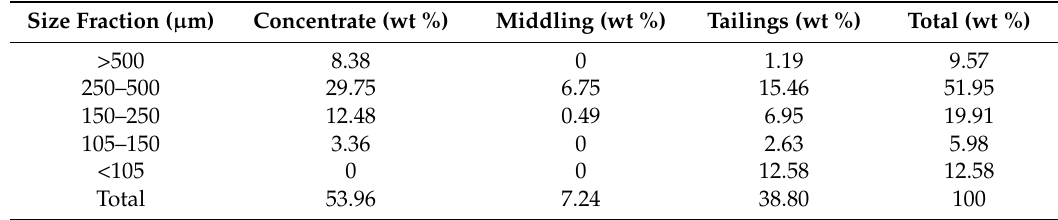
Mass distribution (wt %) of the products in various size fractions following sieving-elutriating